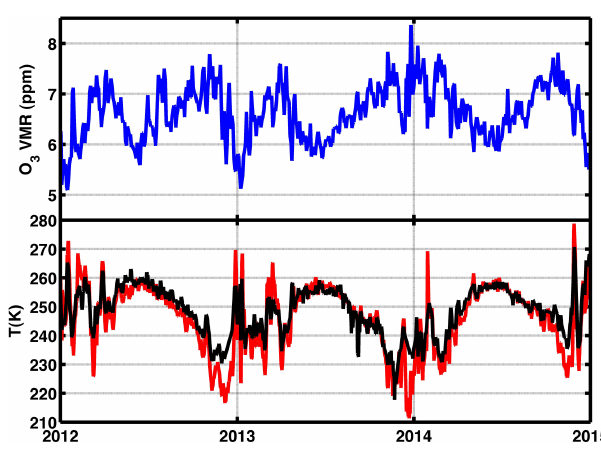
Figure 6. Ozone VMR from GROMOS (blue line), temperature from TEMPERA (black line) and ECMWF (red line) at 3hPa for the period from January 2012 to January